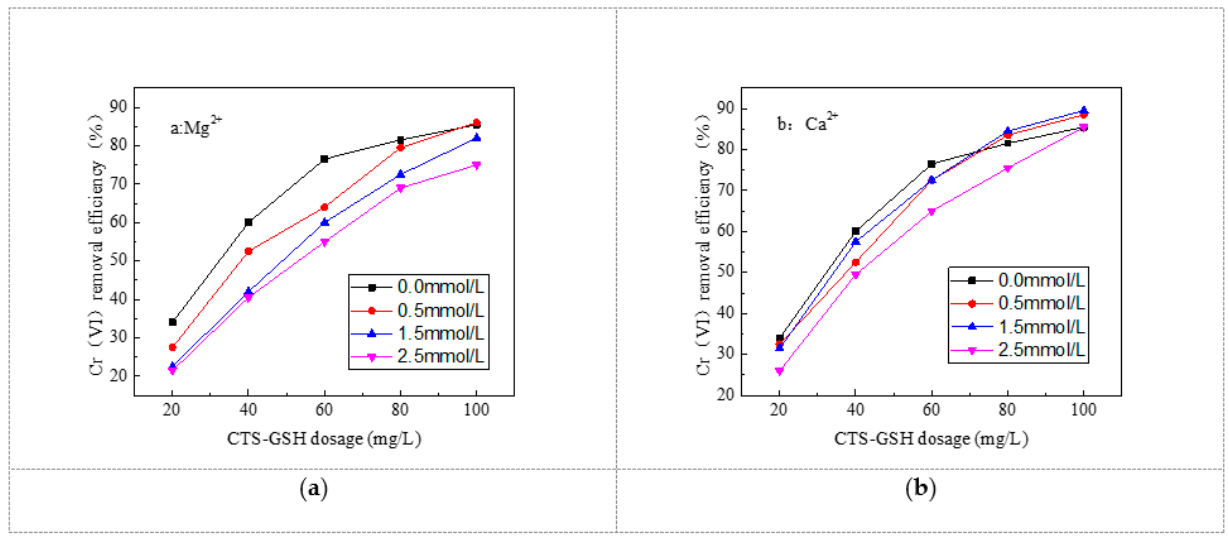
Figure 10. Effect of cations on Cr(VI) removal. ( a ) Effect of Mg2+ on Cr( Ⅵ ) removal. ( b ) Effect of Ca2+ on Cr( Ⅵ ) removal. Ca2+ on Cr(VI)